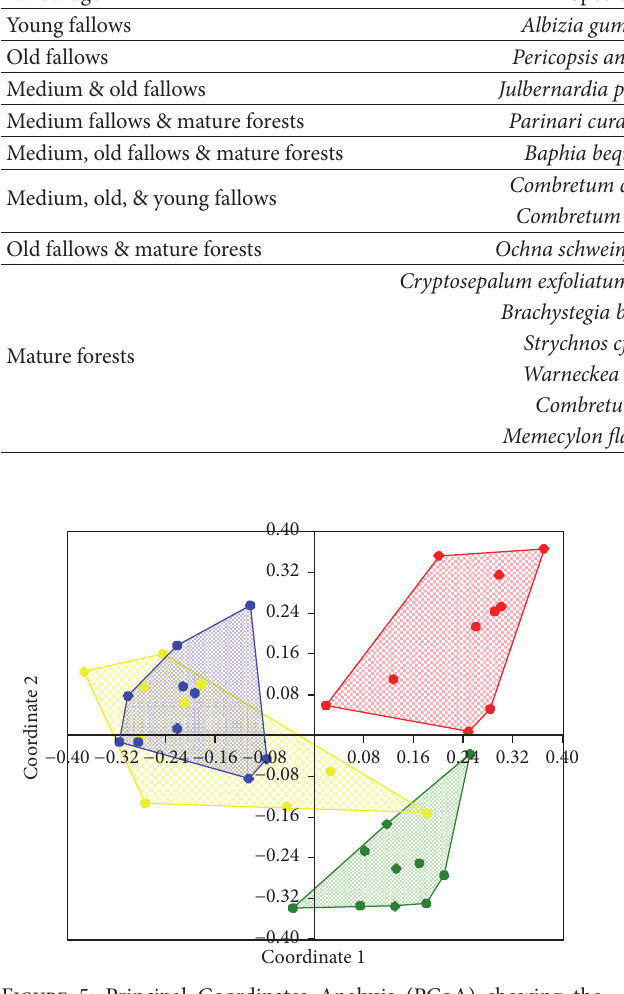
Figure 6: Nonsymmetric Venn diagram showing the number of species shared between the forest stages (young fallows: green; medium fallows: yellow; old fallows: blue; and mature forests: